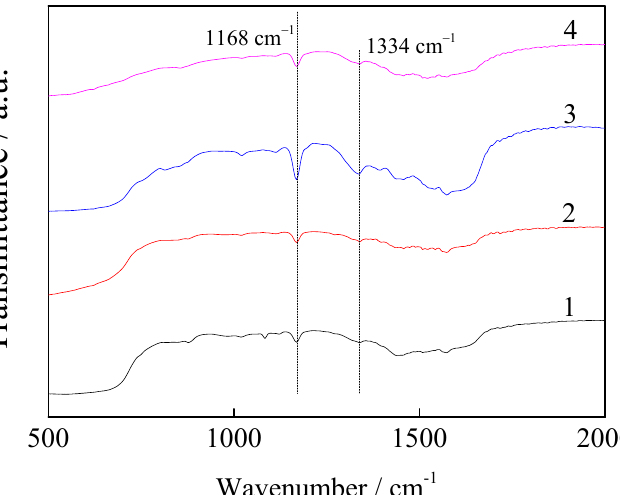
Figure 11. Infrared spectra of magnesite modified by [APMIM]Br with different loading amounts and 30% loading amount of the modified magnesite after adsorption ((1) 10% loading amount; (2) 20% loading amount; (3) 30% loading amount and (4) after adsorption). The BET results are presented in Table 3. The N 2 adsorption-desorption isotherm and the pore size distributions of the magnesite modified by [APMIM]Br before adsorption and after the first cycle are presented in Figure 12. Before adsorption, the BET surface area is 128.5 m 2 /g, the pore volume is 0.2 cm 3 /g and the pore size is 62.5 Å. After the first cycle, the BET surface area is 105.6 m 2 /g, the pore volume is 0.13 cm 3 /g and the pore size